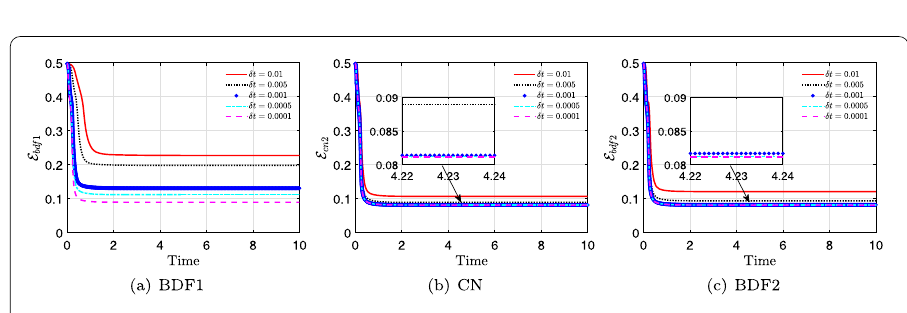
Figure 2 Evolution of modified discrete energies E bdf 1 , E cn , and E bdf 2 , which are calculated by BDF1, CN, and BDF2 for various time steps. The parameters are ε u = ε v = 0.05, M u = M v = 1, α = β = 0.01, σ = 100, S = 10,